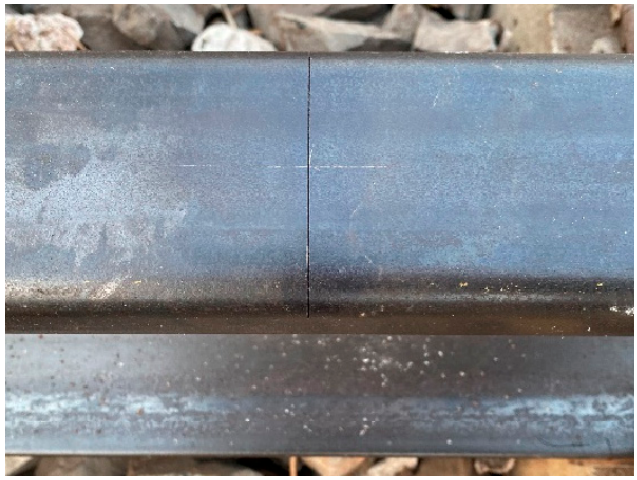
Figure 11. Example of arti fi cial defect of rail.